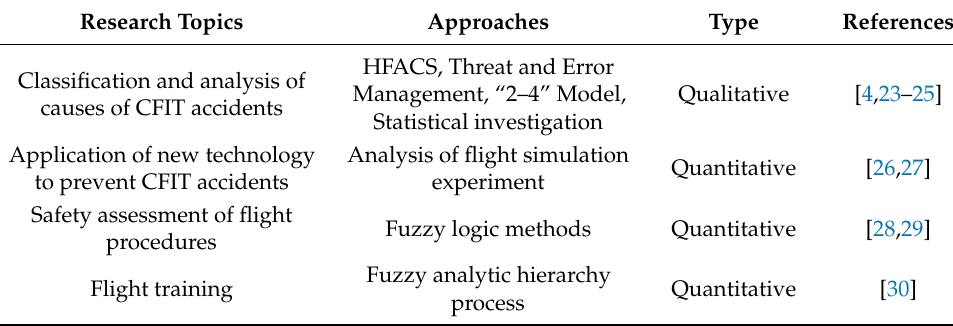
Table 1. Summary of CFIT research topics and